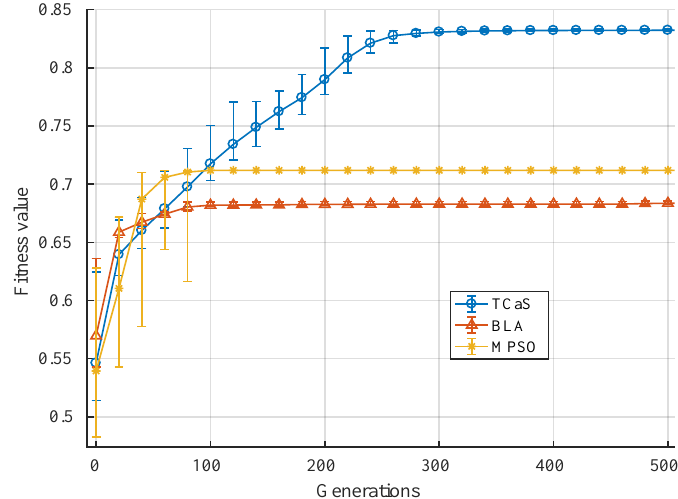
Figure 7. Convergence comparison between three evolutionary